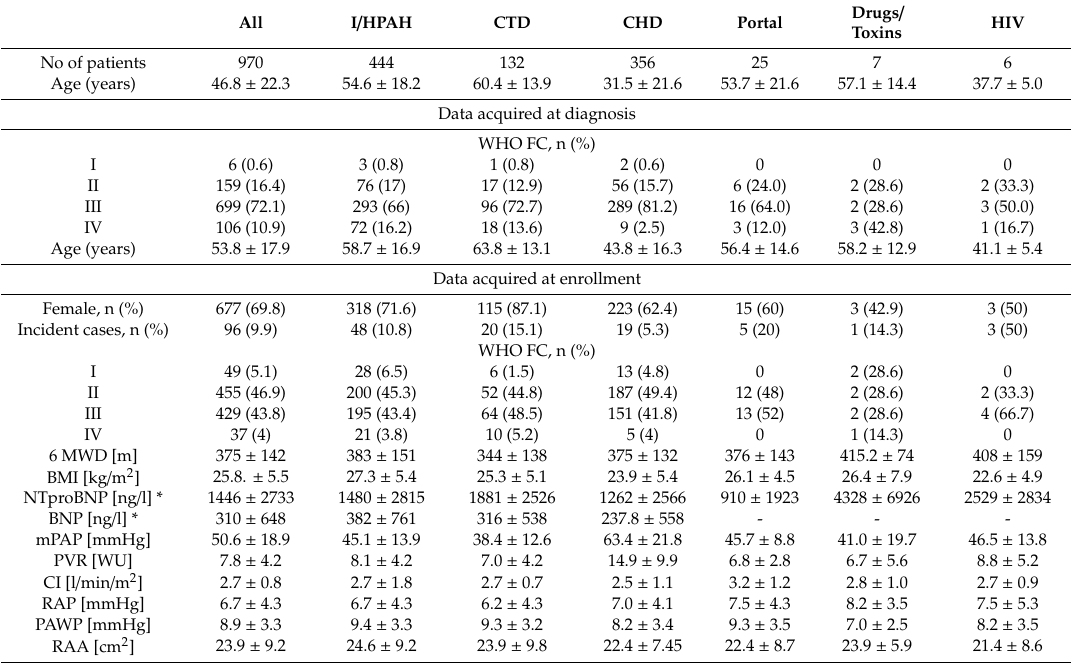
Drugs / HIV Toxins